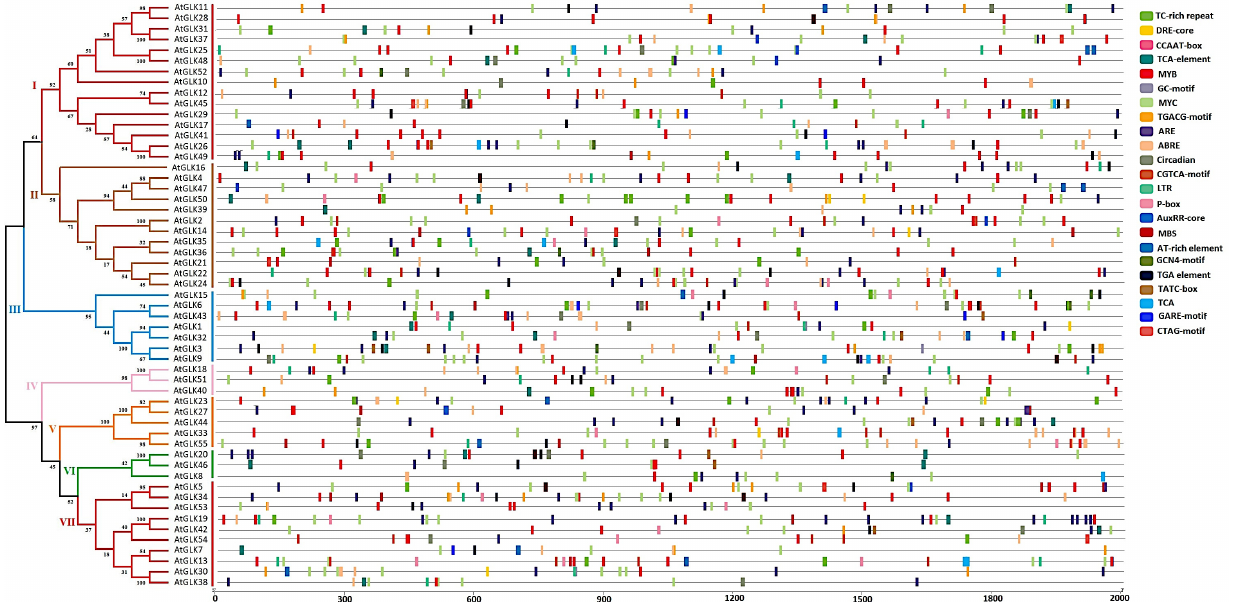
Figure 9. Schematic representation of important cis-elements in the promoter region of AtGLK genes in relation to the phylogenetic classification of their encoded AtGLK proteins. The different types of cis-elements were shown in different